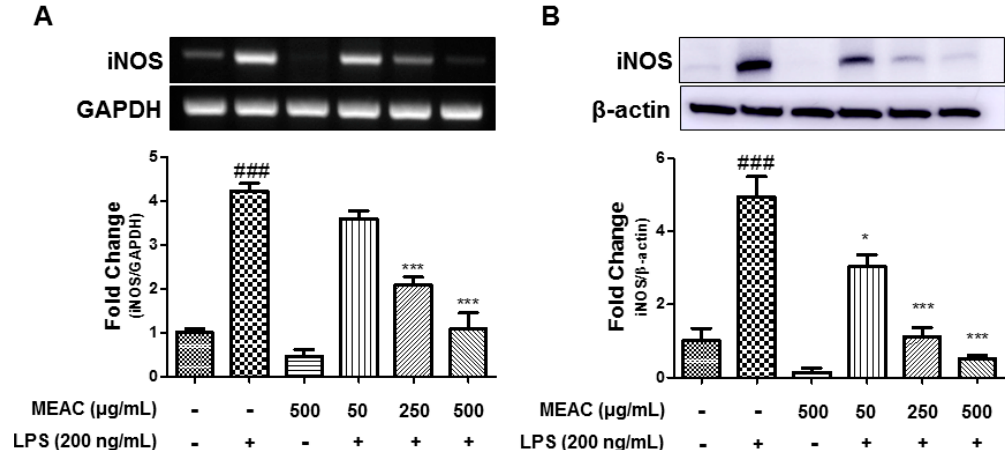
Figure 2. Effect of MEAC on LPS-induced iNOS expressions at mRNA and protein level in BV-2 microglial cells. ( A ) MEAC-treated prevention of iNOS expression at mRNA level. ( B ) The treatment with MEAC protects LPS-stimulated iNOS expression at protein level. Data are presented as the mean ± SEM. ### p < 0.001 versus control group ( n = 3 ); * p < 0.05 and *** p < 0.001 versus LPS group ( n = 3 ).